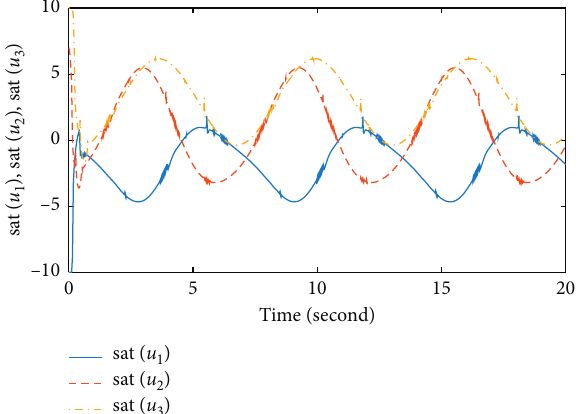
Figure 6: Case 3: the trajectories of sat ( u